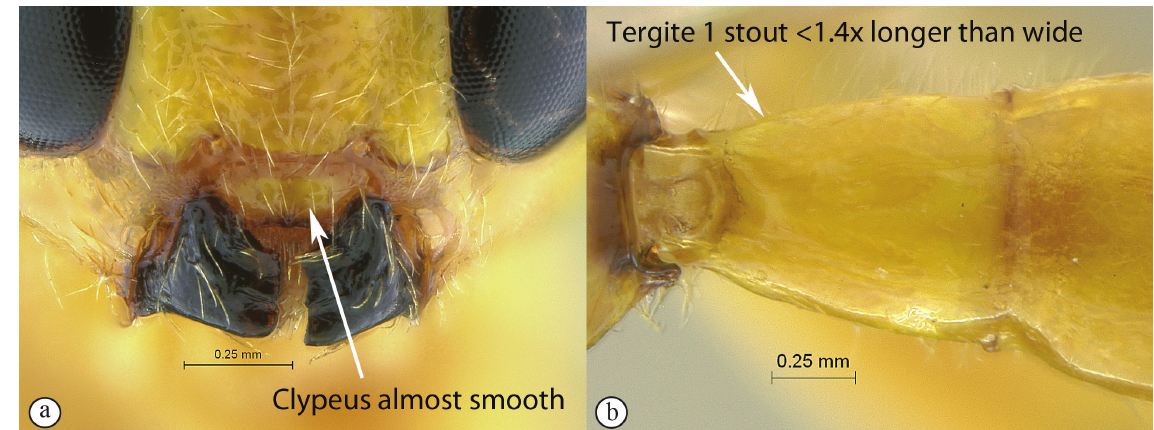
Clypeus almost smooth, hardly sculptured (a); tergite 1 of female stout, less than 1.4x longer than